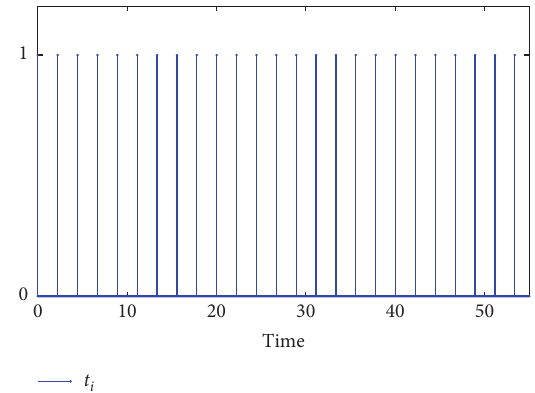
Figure 10: The starting instant of each control of the observer- based T-APIC.